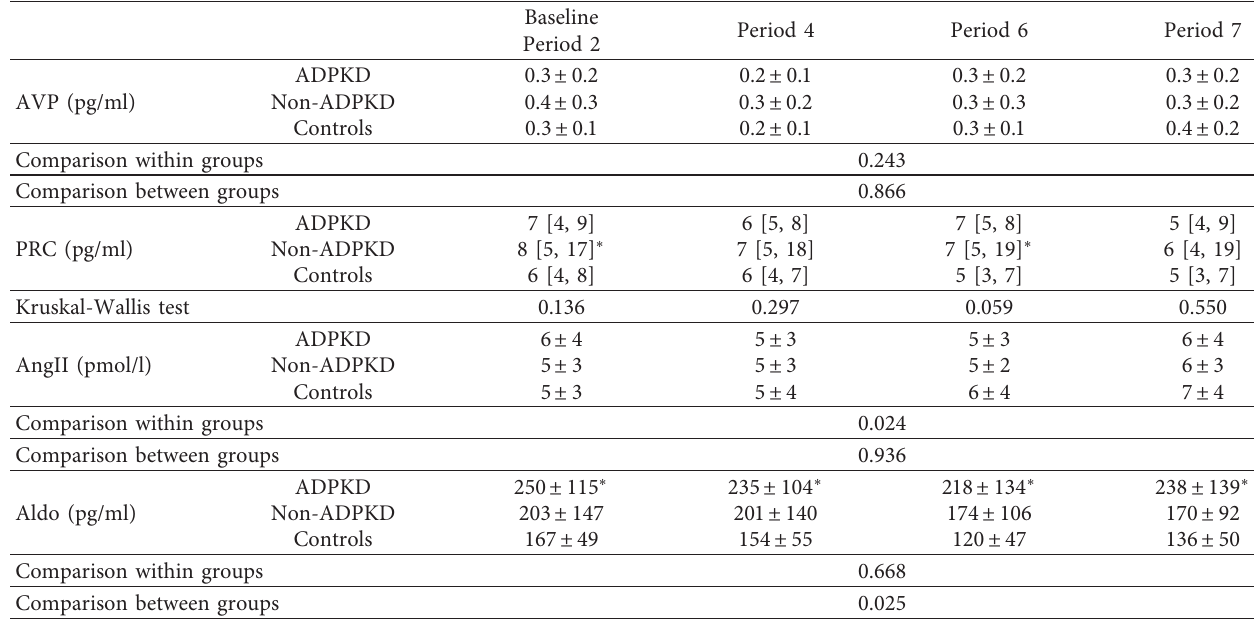
Table 4: Hormones during urine dilution test in patients with adult dominant polycystic kidney disease (ADPKD), patients with non- ADPKD kidney disease (non-ADPKD), and healthy control subjects